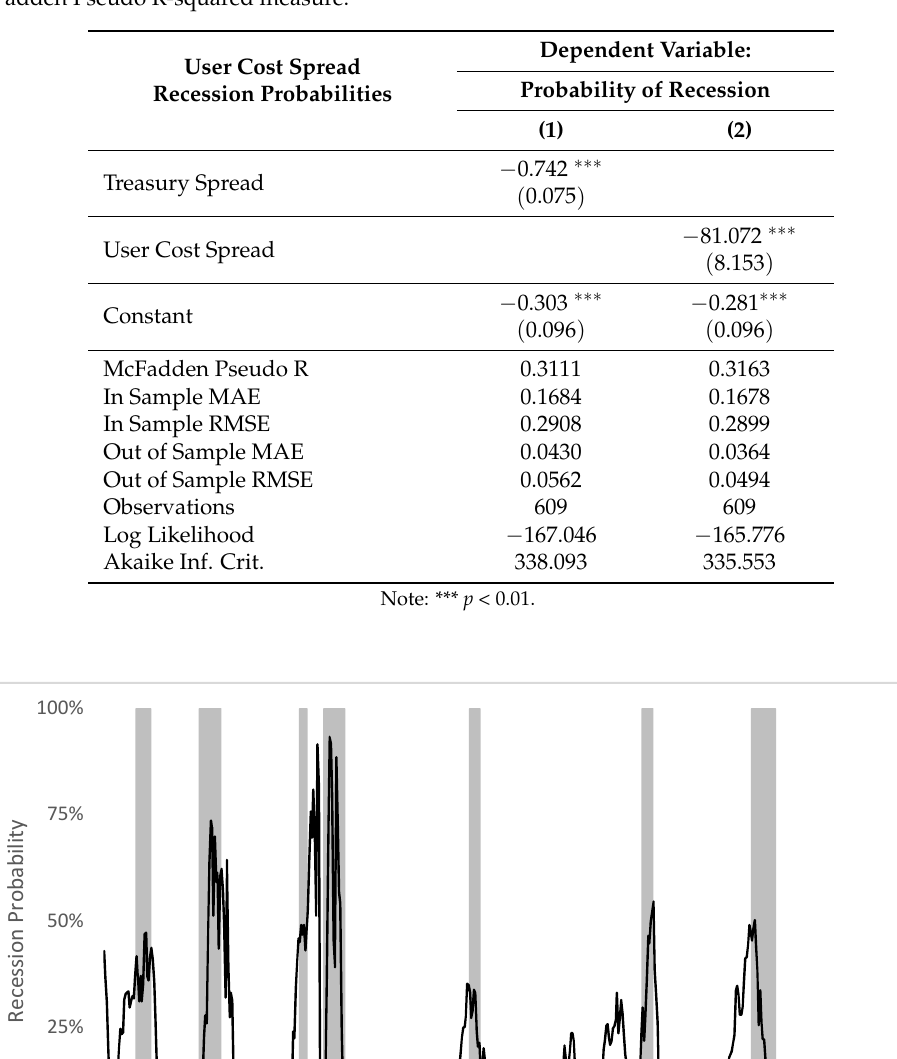
Table 1. R Stargazer Results Table for User Cost and Yield Spread Recession Predictions. MAE refers to Mean Absolute Error and RMSE to Root Mean Squared Error. McFadden Pseudo R refers to the McFadden Pseudo R-squared measure.